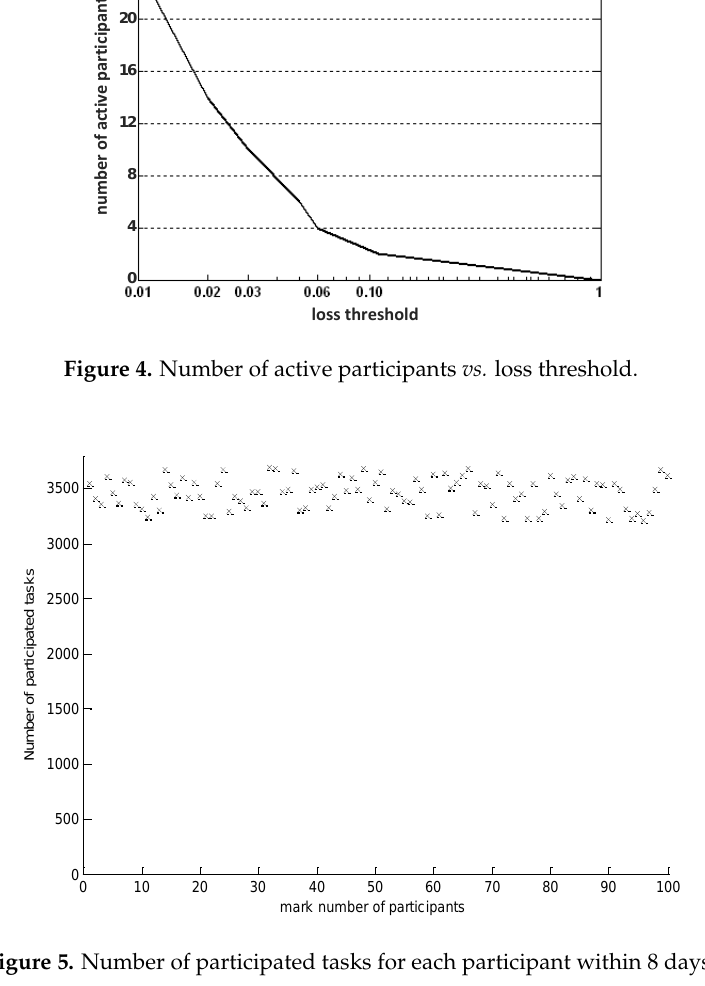
Figure 4. Number of active participants vs. loss threshold.